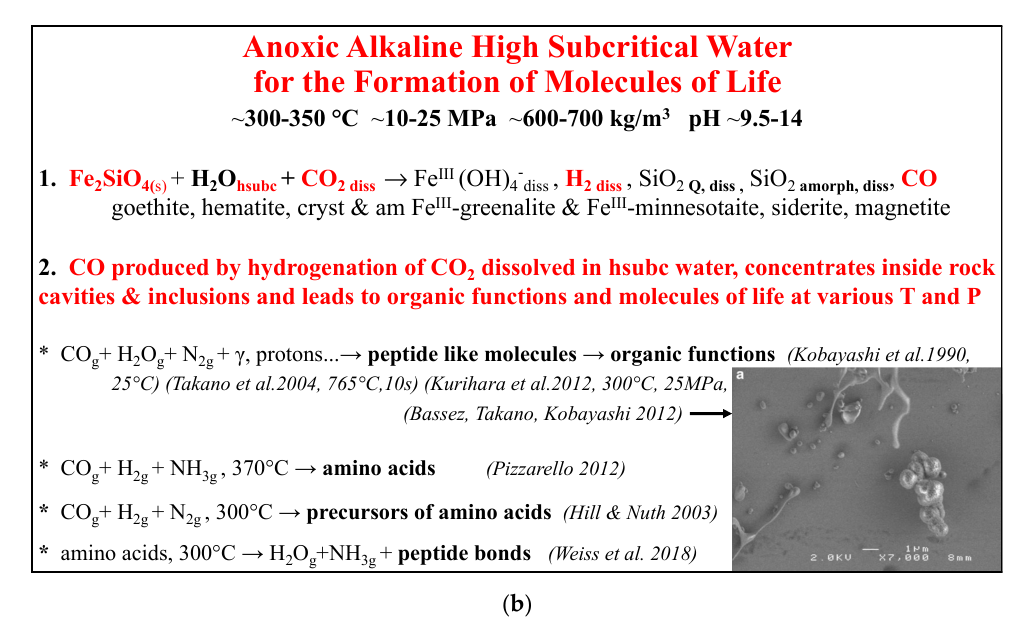
Figure 4. The concept of geobiotropy, which represents the transformation in anoxic alkaline high subcritical water, of rocks that contain ferrous silicates, for the production of ferric minerals and macromolecules of life. ( a ) describes the five processes in high subcritical water, that lead to the formation of ferric minerals and CO. ( b ) describes experiments on the synthesis of molecules of life either at low T with irradiation or at higher T. The equations show the products but are not all chemically equilibrated. diss = dissolved; hsubc = high subcritical; supc = supercritical; hsubcw = high subcritical water; Q = quartz; amorph = amorphous; s = solid; am = amorphous; cryst = crystalline; g = gas; γ = gamma rays.